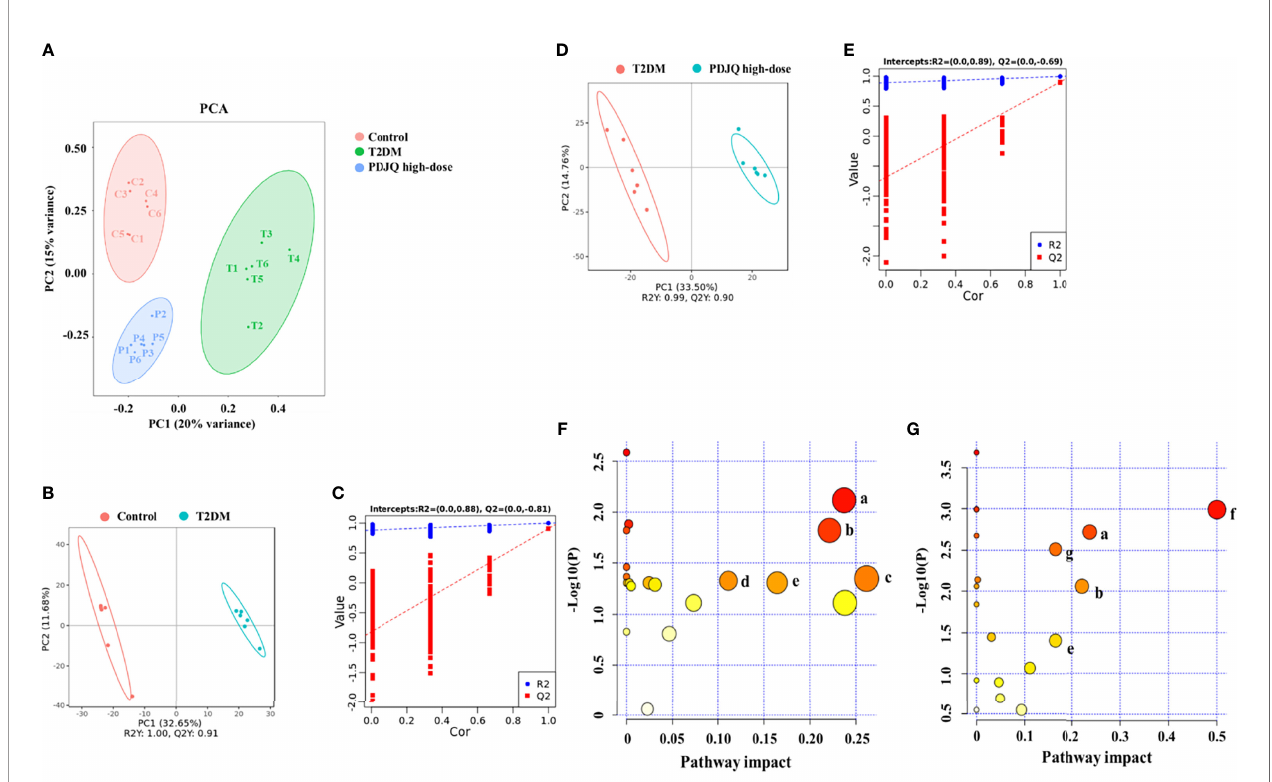
FIGURE 4 | PDJQ treatment regulated the serum metabolites in T2DM rats. (A) Scores plots of PCA between the control and T2DM groups and the T2DM and PDJQ high-dose groups. (B, C) Scores plots of OPLS − DA between the Control and T2DM groups and the corresponding coef fi cient of loading plots. (D, E) Scores plots of OPLS − DA between the T2DM and PDJQ high-dose groups and the corresponding coef fi cient of loading plots. (F, G) Summary of pathway analysis of serum samples between control and T2DM groups and between T2DM and PDJQ high-dose groups. (A) Tryptophan metabolism; (B) Histidine metabolism; (C) Glycerolipid metabolism; (D) Glyoxylate and dicarboxylate metabolism; (E) TCA cycle; (F) Phenylalanine, tyrosine and tryptophan biosynthesis; (G) Tyrosine metabolism. Control, T2DM and PDJQ high-dose (n = 6 per group)